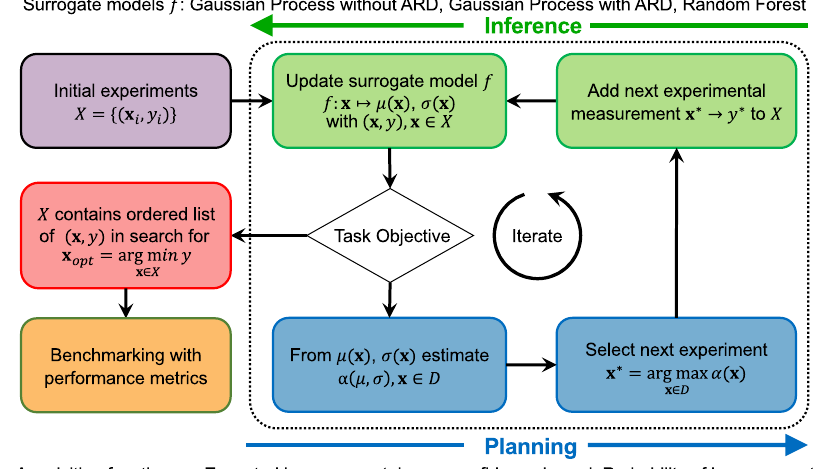
Fig. 2 Benchmarking framework including a simulation of BO performing closed-loop optimization with alternating inference and planning stages. X is the iteratively collected sequence of experimental data ( x , y ) during the optimization campaign. D is the original pool or total undiscovered set of data from which the next experiments are selected. f is the surrogate model used to estimate mean ^ μ and standard deviation ^ σ , which parameterize the acquisition function α to select next experiment x * to be